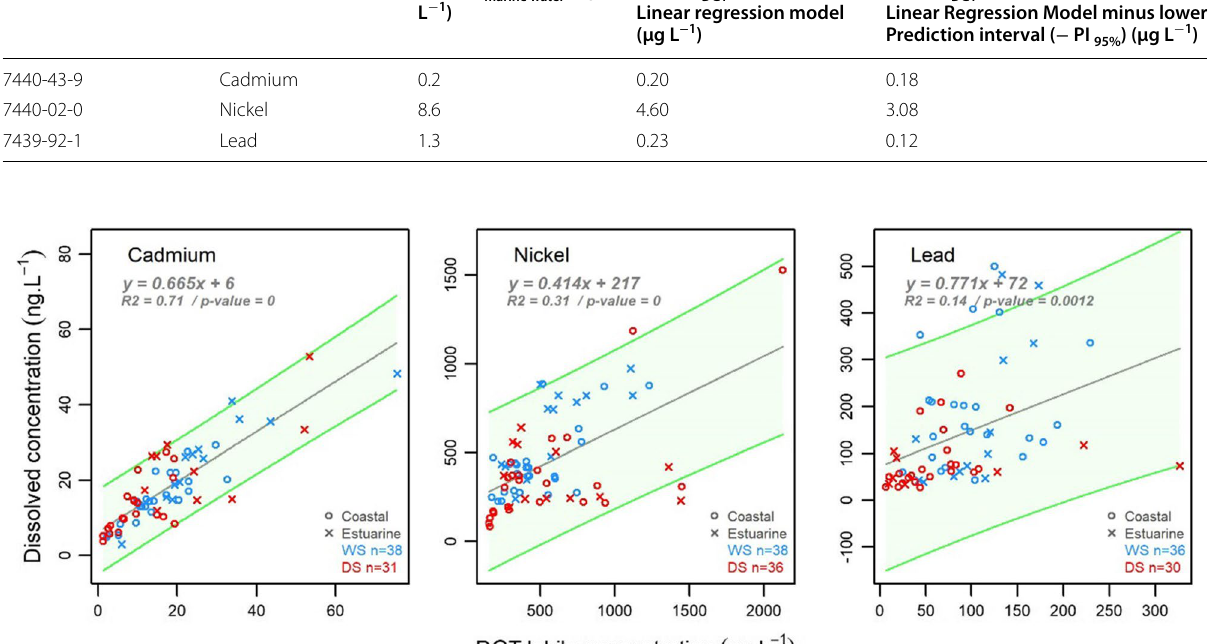
The mean and lowest predicted concentrations and the validity range are shown Table 3 AA‑EQS expressed in µg L − 1 [30] and (A)‑EQS marine water